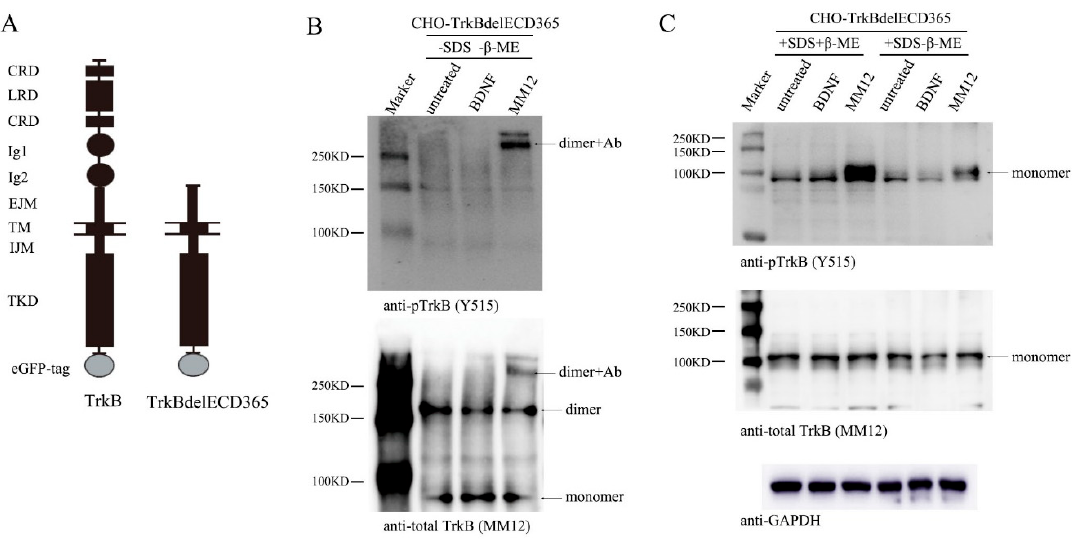
Figure 3. Stimulation of TrkB EJM activates preformed dimers. ( A ) Constructs of TrkB and TrkBdelECD365, both with a GFP tag. ( B ) MM12 but not BDNF induces TrkBdelECD365 tyrosine phosphorylation, only in its dimer form. Stable CHO cell line expressing TrkBdelECD365 was stimulated with BDNF or MM12 (1.0 nM, at 37 ◦ C). Cell lysates (2 µ g / lane) were subject to native-PAGE without SDS nor β -ME and Western blotting. The blots were probed anti-pTrkB (Y515) and total TrkB (MM12). ( C ) Denaturing agent SDS disrupts TrkBdelECD365 dimer formation. The experiments were done exactly the same as B except SDS, with or without β -ME, was applied to treat the cell lysates. Again, MM12 but not BDNF activates TrkBdelECD365, but only in its monomer form. The experiments in both ( B ) and ( C ) were repeated at least three times and representative blots are shown.